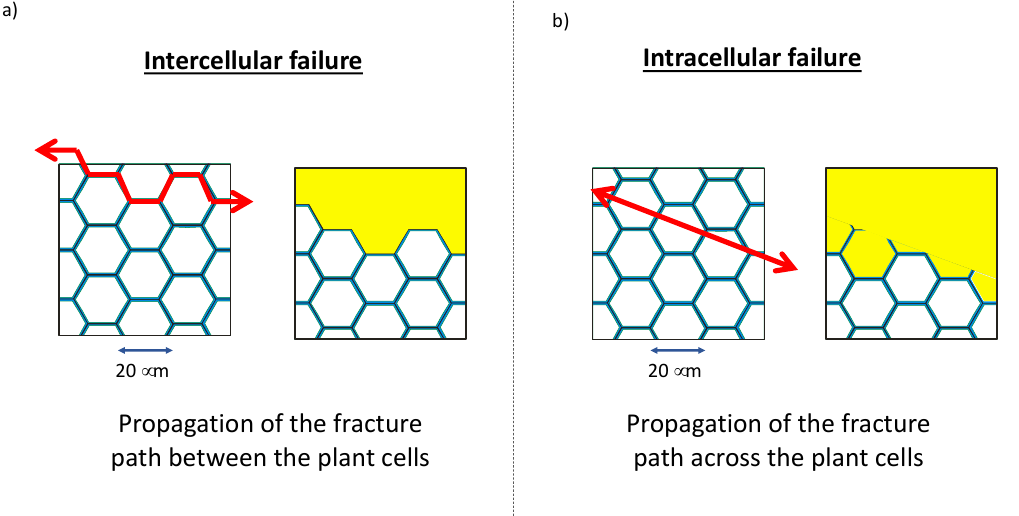
Figure 5. Intercellular failure ( a ) and Intracellular failure ( b ) observed during the milling of cork with impact and shear as main mechanical stresses, respectively [50]. (Tissue scale).